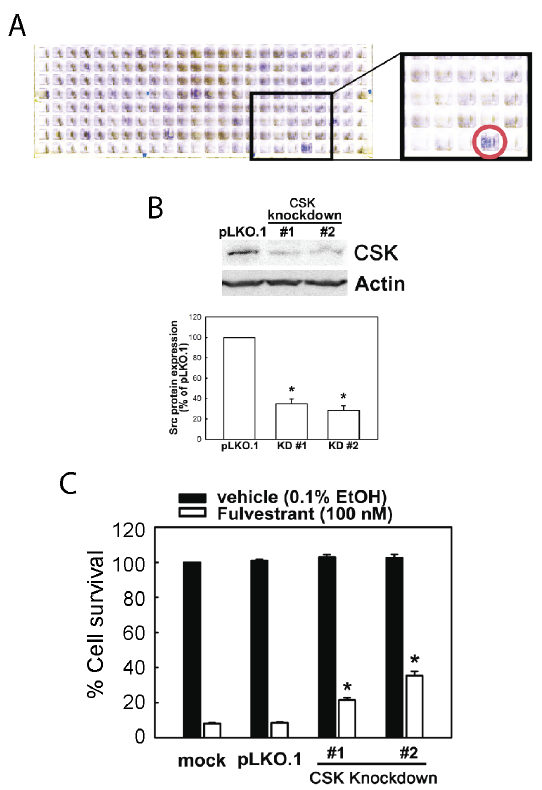
Figure 1. RNAi knockdown of CSK in MCF-7 cells causes resistance to fulvestrant. (A) RNAi knockdown screening reveals dependence of fulvestrant-induced MCF-7 cell death on CSK. Cells infected with lentiviruses expressing shRNA to CSK (well is identified by red circle) survived after 7 days of exposure to 100 nM fulvestrant. Crystal violet staining of a representative screening plate is shown. (B) Knockdown of CSK protein expression by shRNA lentiviruses. Cells were infected with empty lentivirus vector (pLKO.1) or two independent clones of lentiviruses expressing different shRNA species targeting CSK shown in Figure 1 (CSK KD # 1 and # 2) and subjected to Western blotting quantitation of CSK protein expression (top). Intensities of CSK protein bands were determined by densitometry as shown in the bar graph (bottom, mean 6 SEM of three independent experiments. Asterisk indicates statistical significance, p , 0.05). (C) Infection by lentiviruses expressing shRNA targeting CSK causes fulvestrant resistance of MCF-7 cells. Cells were infected with empty lentivirus vector (pLKO.1) or two independent clones of lentiviruses expressing different shRNA species targeting CSK (CSK KD # 1 and # 2) and exposed to fulvestrant, or vehicle for 7 days. % Cell survival (mean 6 SEM) was determined by three independent experiments. *, p , 0.001 to both mock infected and pLKO.1-infected controls exposed to fulvestrant). No significant changes were observed with cell survival ratio of any virus-infected cells compared to mock infected control.